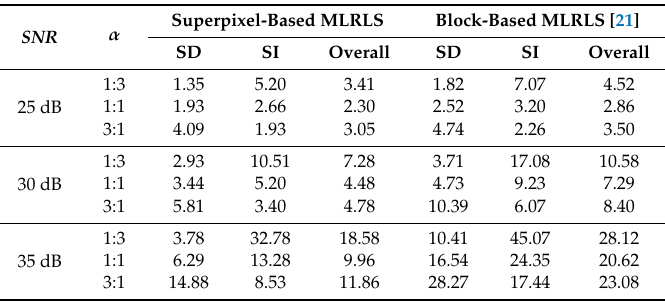
Table 7. The optimal relative errors of the SD noise, the SI noise and the overall optimization for 1:2 spectral subsampling